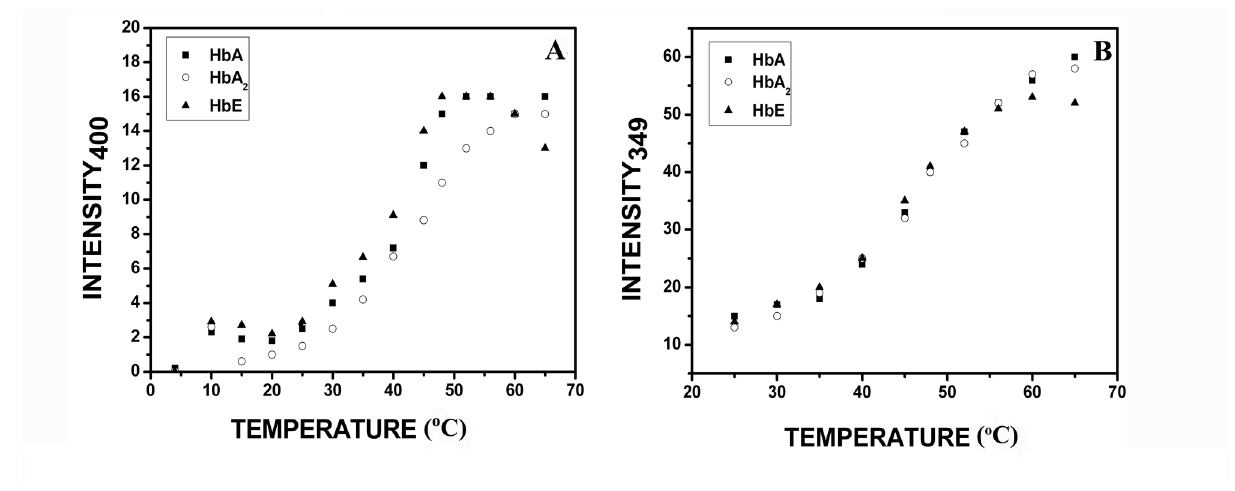
Figure 5. Changes in intensities of (A) for dityrosine (Ex 315 nm, Em 400 nm) formed and (B) synchronous fluorescence of tyrosine in HbA, HbA and HbE (5.0 µM) as a function of temperature at pH 11.5. The complete scan for the spectra related to 2 ( A ) and ( B ) are presented in Figures S1 and S2 respectively.